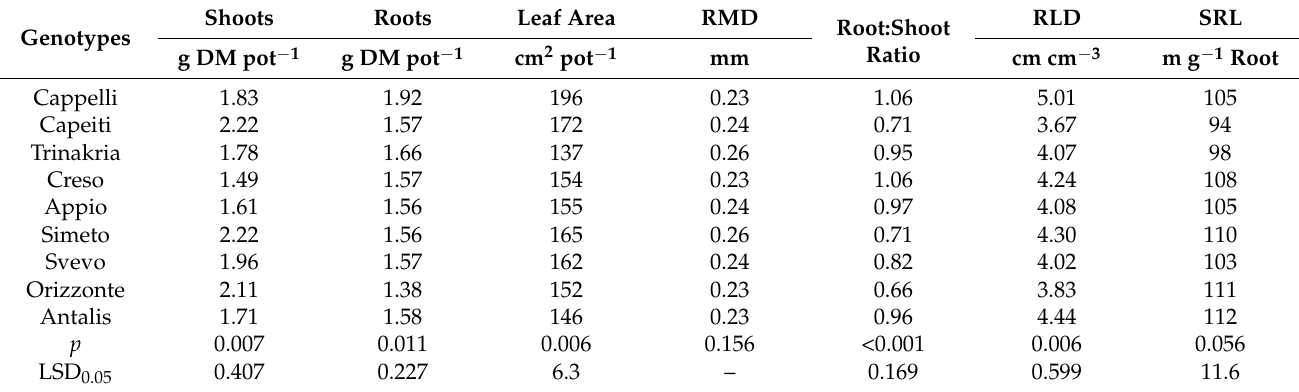
Table 2. Shoot and root biomass, leaf area and root traits for the nine studied genotypes at 90 days after emergence (Time 1).